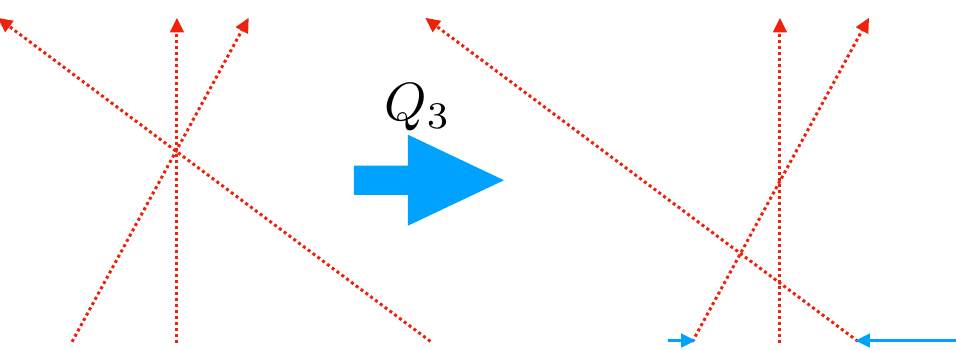
Figure 6: The Q flow in integrable models. Because the displacement is proportional 3 to the square of the momentum, a three-body process is factorised into well separated two-body